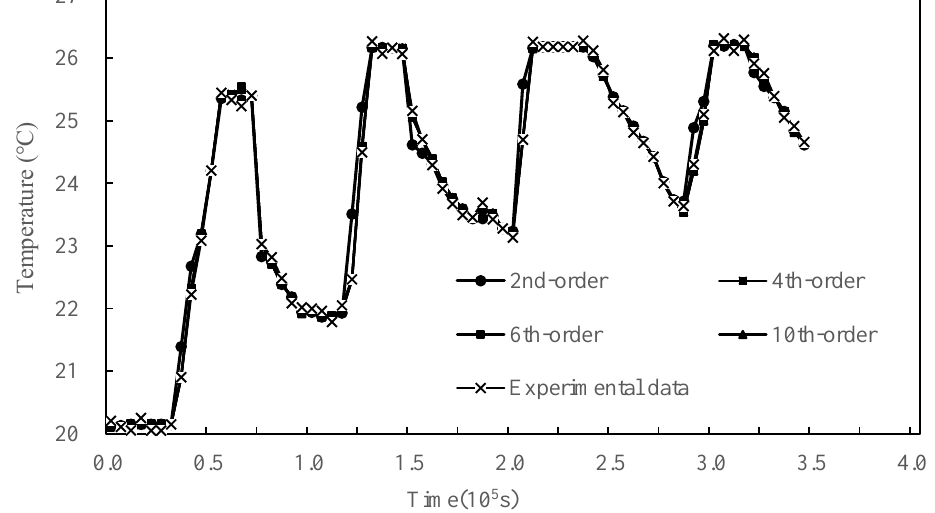
Figure 8. Choice of reduction order. Table 2. Contribution of each order.